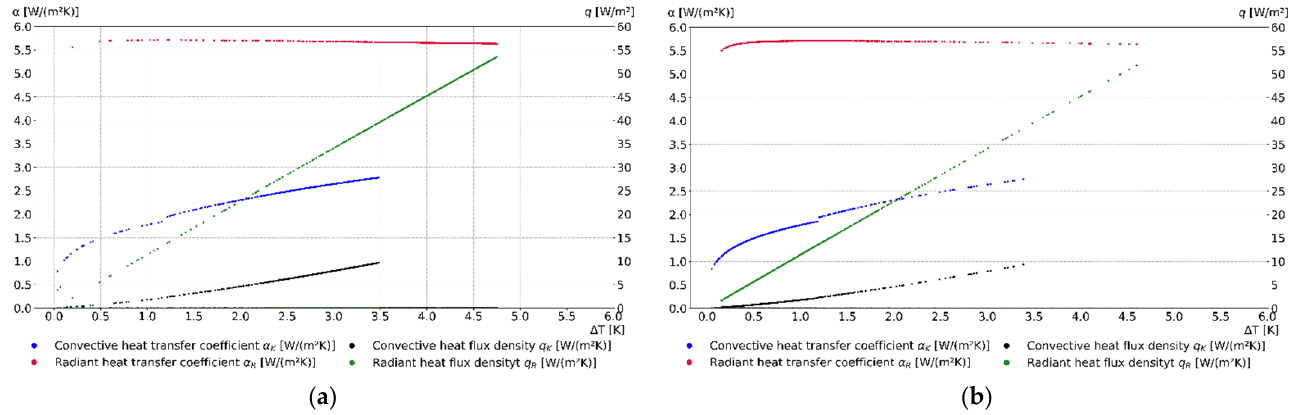
Figure 13. Quasi-steady-state conditions—( a ) activation time c, ( b ) work hours.